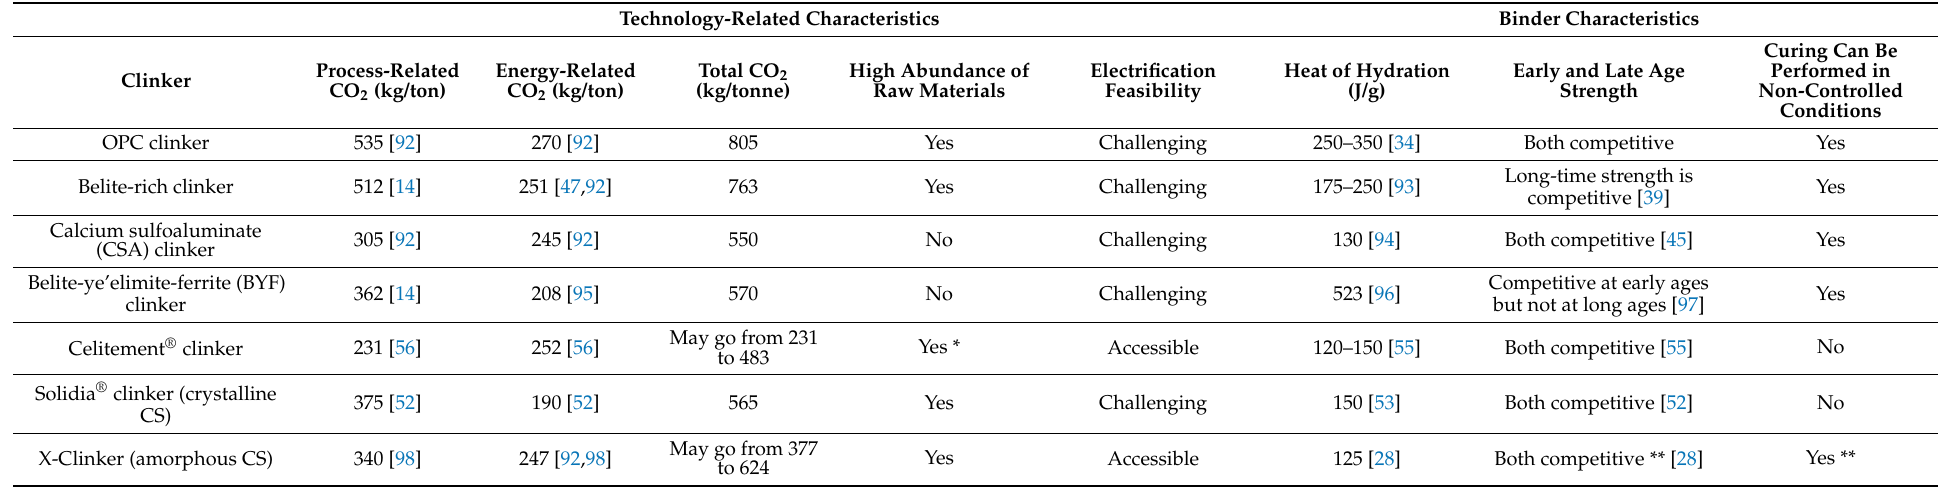
Table 1. Technology-related and binder characteristics of the ACTs